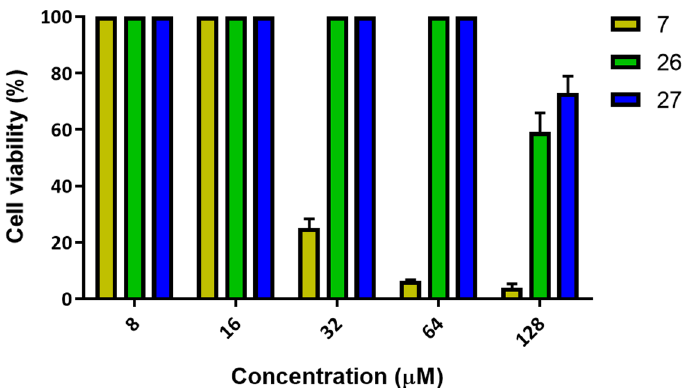
Figure 4. HaCaT cells viability after 24 h treatment with compounds 7 , 26 , and 27 compared to the untreated control cells, as determined by the MTT assay. Data are expressed as the mean of three independent experiments ± SEM.